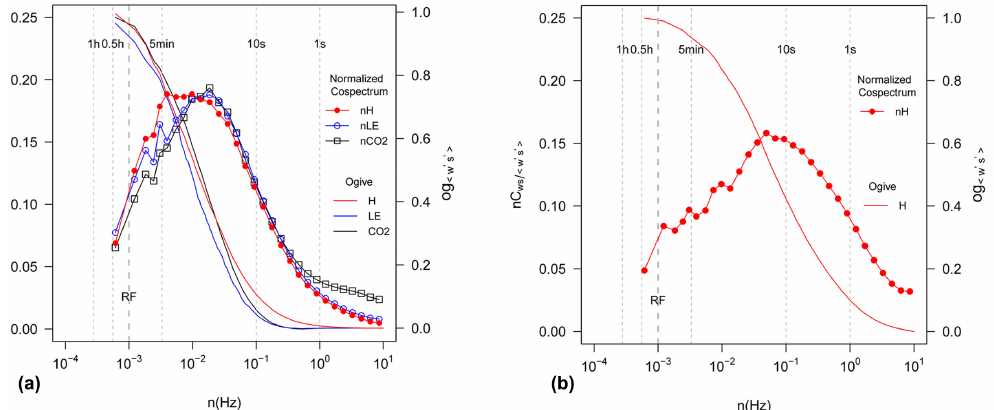
Figure 6. Normalized turbulence co-spectra ( y axis, lines + symbols) and converging ogives (secondary y axis, lines) of sensible heat (red), latent heat (blue) and CO 2 flux (black) during unstable conditions for Basel (a) and Degerö (b) . The vertical line labeled as RF indicates the time constant of the applied high-pass filter. At Degerö only high-resolution air temperature data were